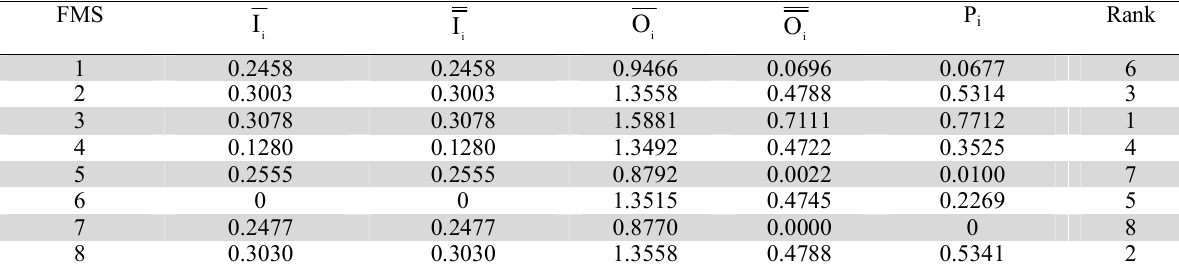
Computation details for OCRA